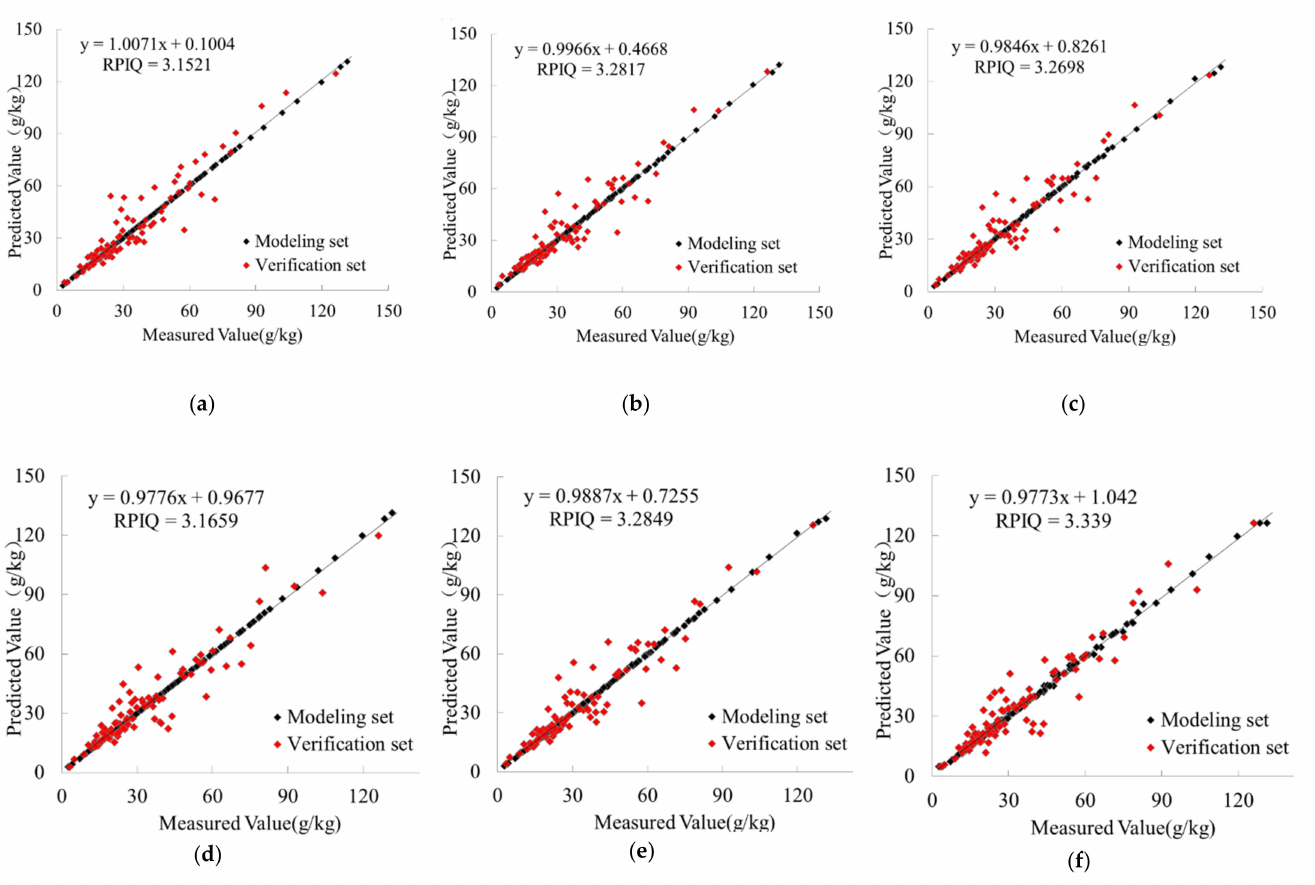
Figure 6. Scatter diagrams of six representative prediction models. ( a ) MSCFD–XG, ( b ) Stack 1, ( c ) Stack 2, ( d ) Stack 3, ( e ) Stack 5 and ( f ) Stack